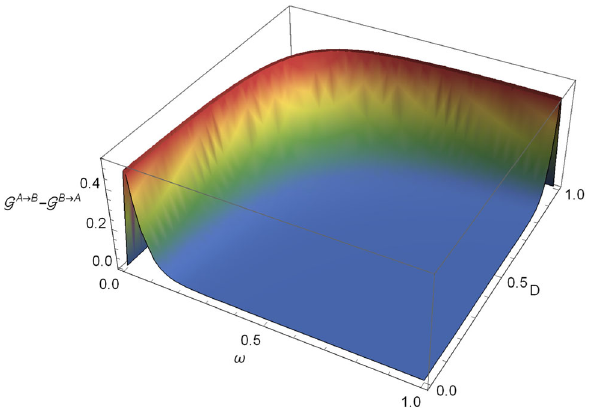
Fig. 2 The Gaussian steerability asymmetry between A and B as a function of the dilaton parameter D and the frequency ω in the GHS dilaton spacetime. The initial squeezing parameter and mass parameter are fixed as s = 1 and M = 1,